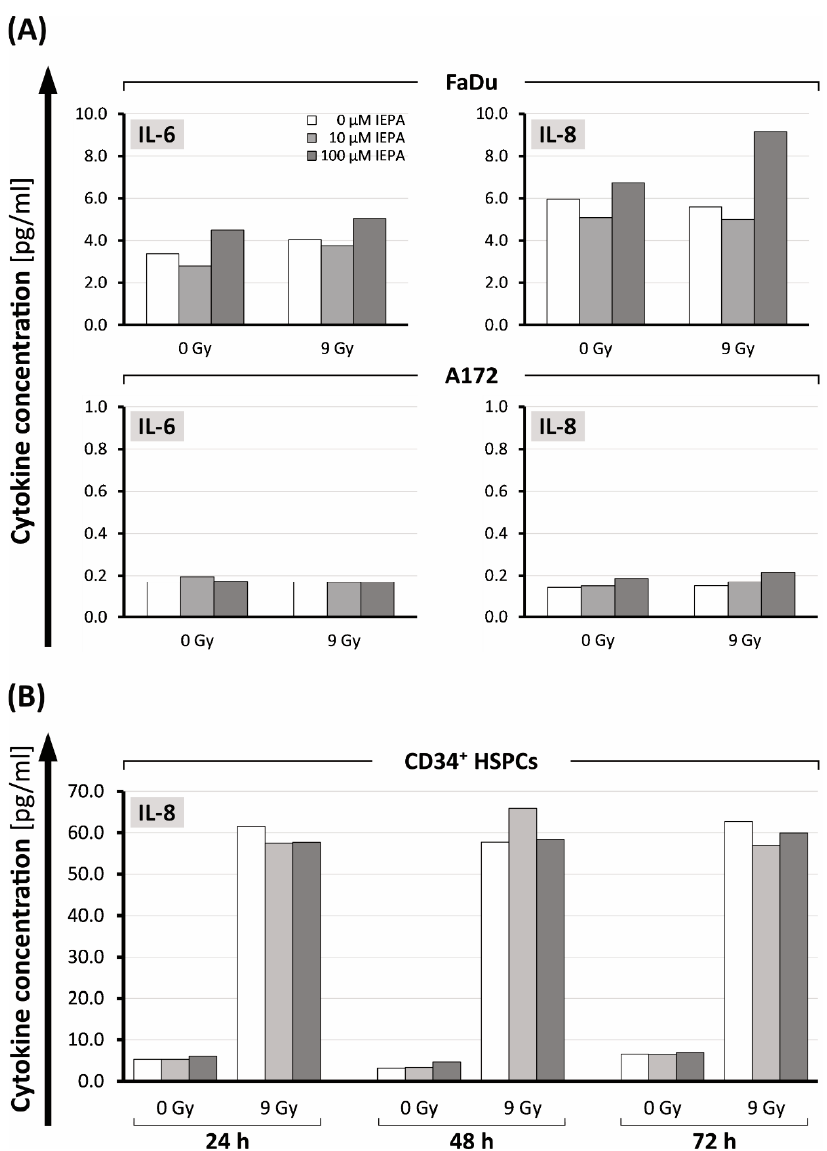
Figure 6. ( A ) IL-6 and IL-8 release 24 h after treatment with IEPA (10, 100 µM) as well as IR (9 Gy) in FaDu cells and A172 cells. ( B ) IL-8 levels in CD34 + HSCPs 24, 48, 72 h after IEPA application (10, 100 µM) and IR (9 Gy). All analyte concentrations obtained using flow-cytometric bead array (CBA) in one experiment with single measurements.